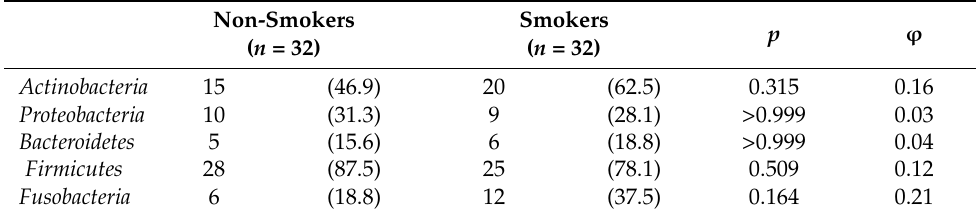
Table 2. Prevalence of bacteria at the genus level.